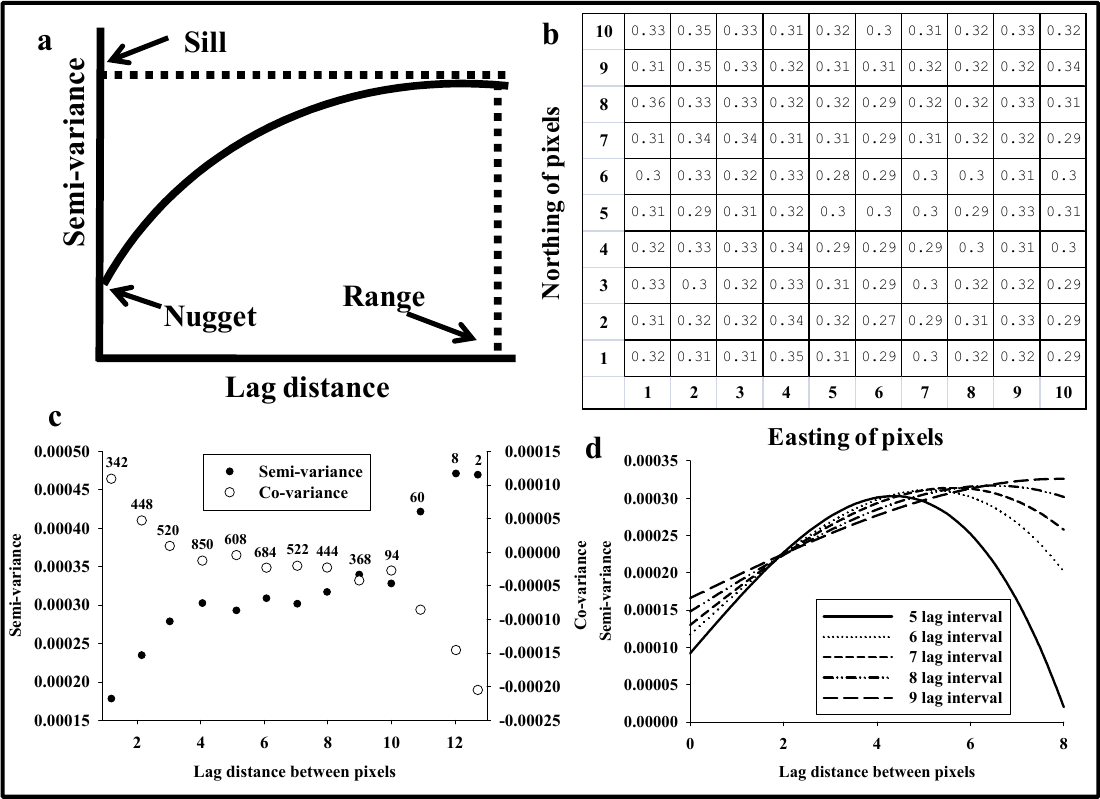
Figure 1. Basic description of variogram analysis applied to reflectance